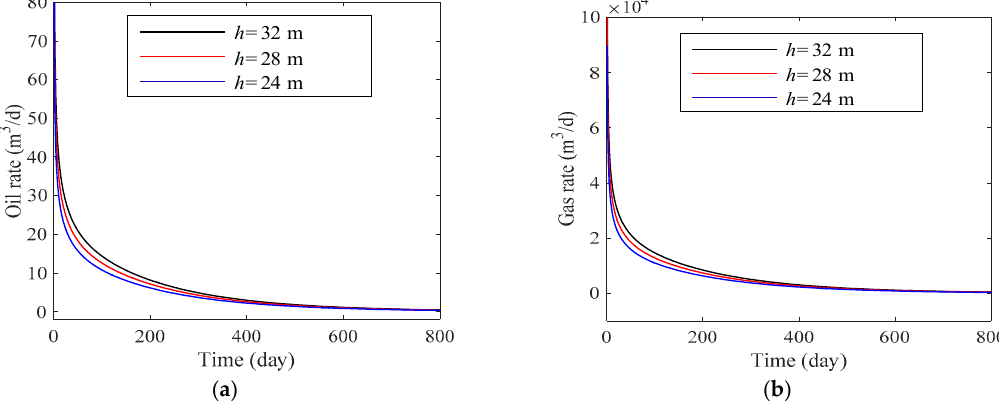
Figure 10. Effect of length of horizontal well section on production rate: ( a ) effect of length of horizontal well section on oil production rate; ( b ) effect of length of horizontal well section on gas production rate.